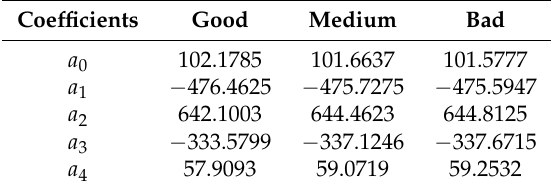
Table 2. Optimal coefficients a k , k = 0,1, . . . ,4 for the polynomial control (23) and the three examples that we consider: good quality MoS 2 layer at R = 3.5 nm, medium quality MoS 2 layer at R = 6